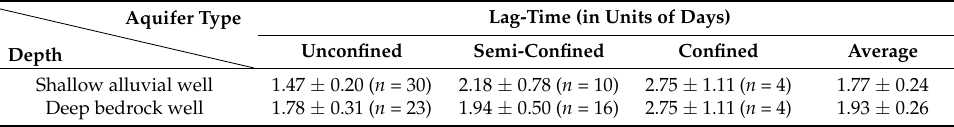
Table 5. Results of the lag-time for depths and aquifer